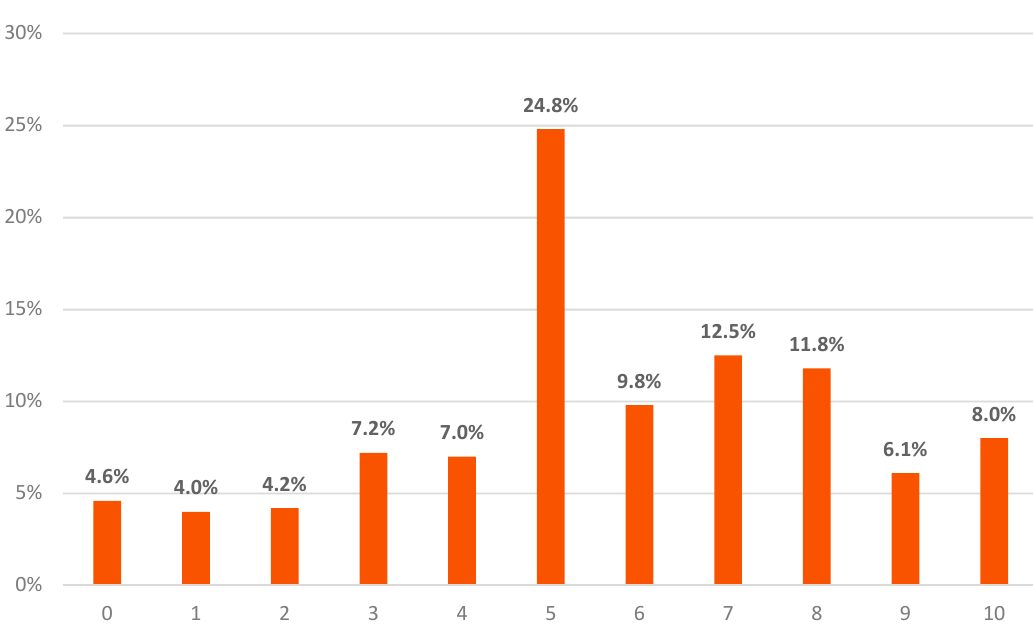
Figure 6. Self-assessment of the improvement in decision-making as a result of participation in the ARSET program. Values indicate the percentage of respondents who selected each option. In the 11-point scale used, 0 = did not change, and 10 = improved a great deal ( N = 899).